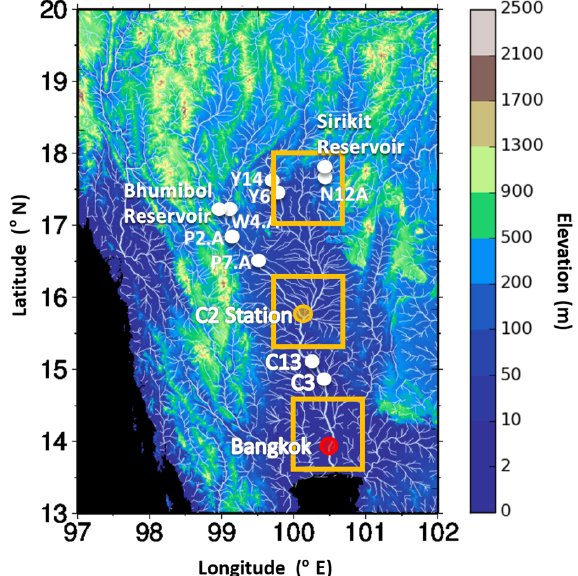
Figure 1. The Chao Phraya River Basin. Model domain, elevation map, river network, and validation stations. The orange dot marks the location of the station used for calibration. White dots mark the stations used for validation. The red dot marks the capital of Thai- land, Bangkok. Areas in orange squares are zoomed in for analysis of